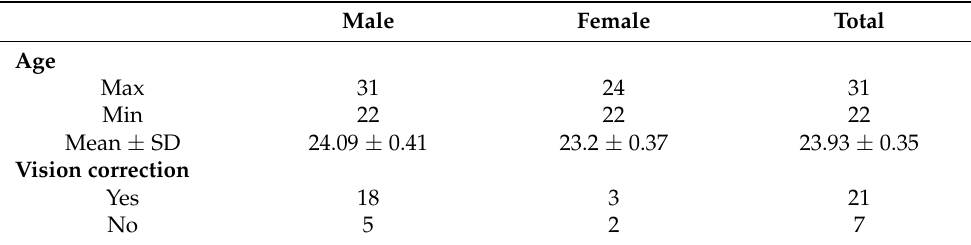
Table 3. Basic information of